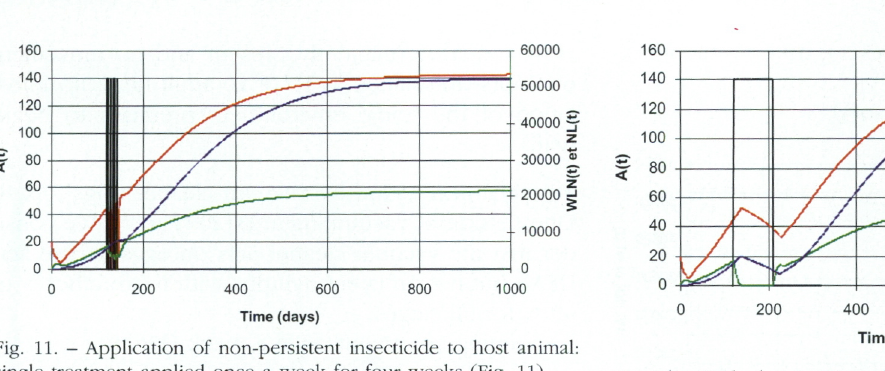
Fig. 14. - Oral administration of IGR on host animal at D 120, D 150 and D 180, or treatment over three successive months (Fig. 14).